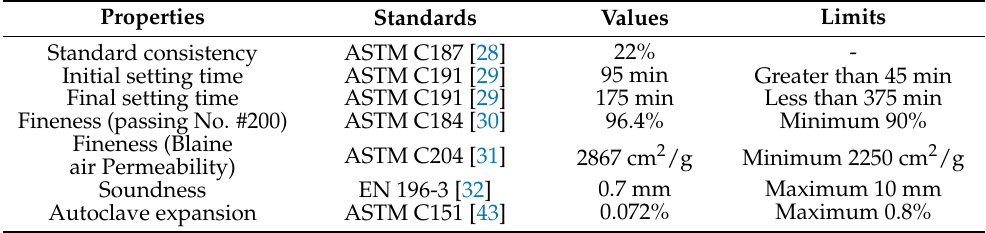
Table 4. Physical properties of cement.